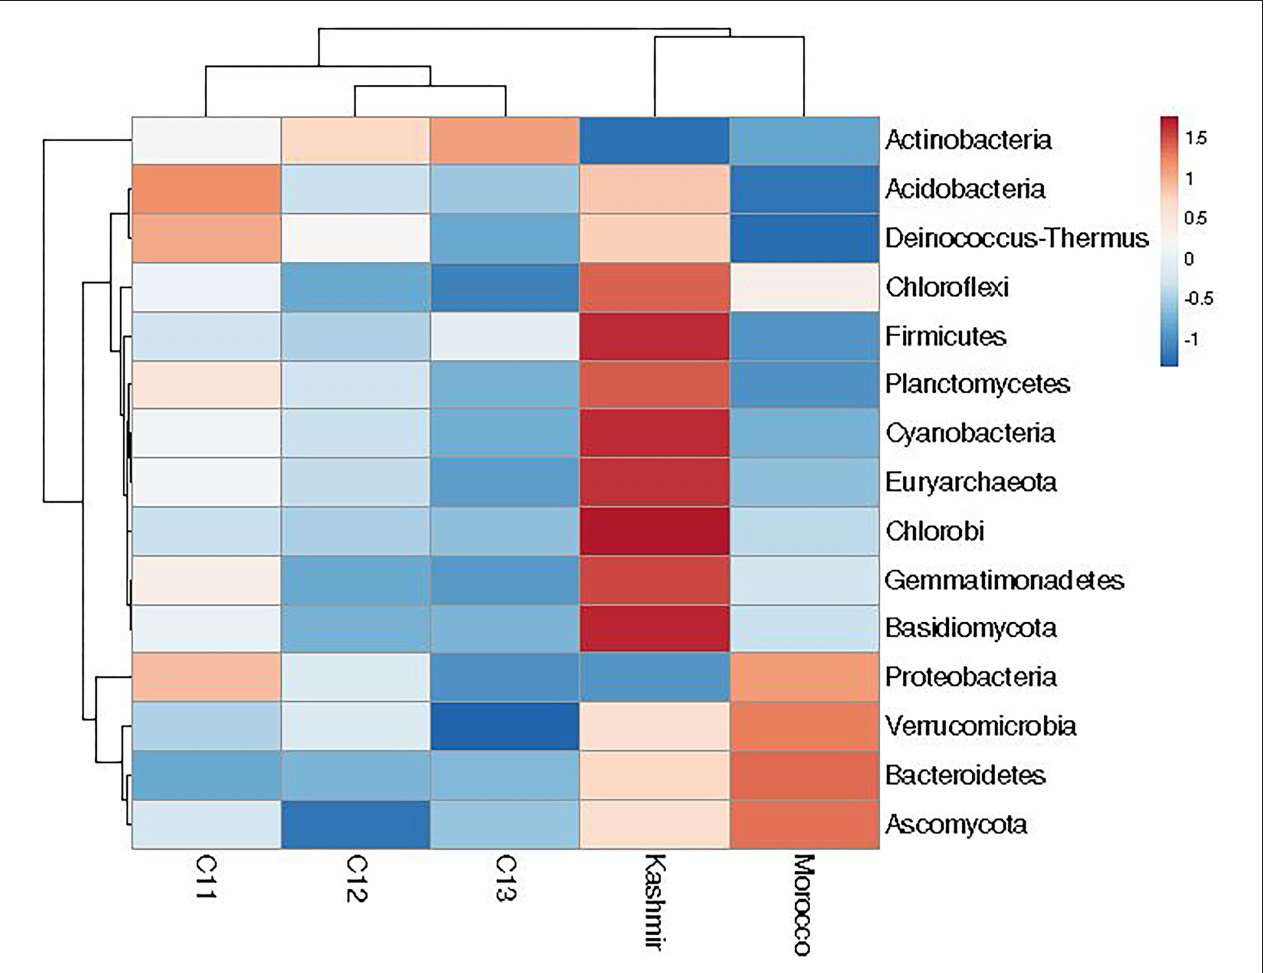
FIGURE 7 | Relative abundance of 15 phyla in the saffron cormosphere from all the three geographical locations (Kashmir, Kishtwar, and